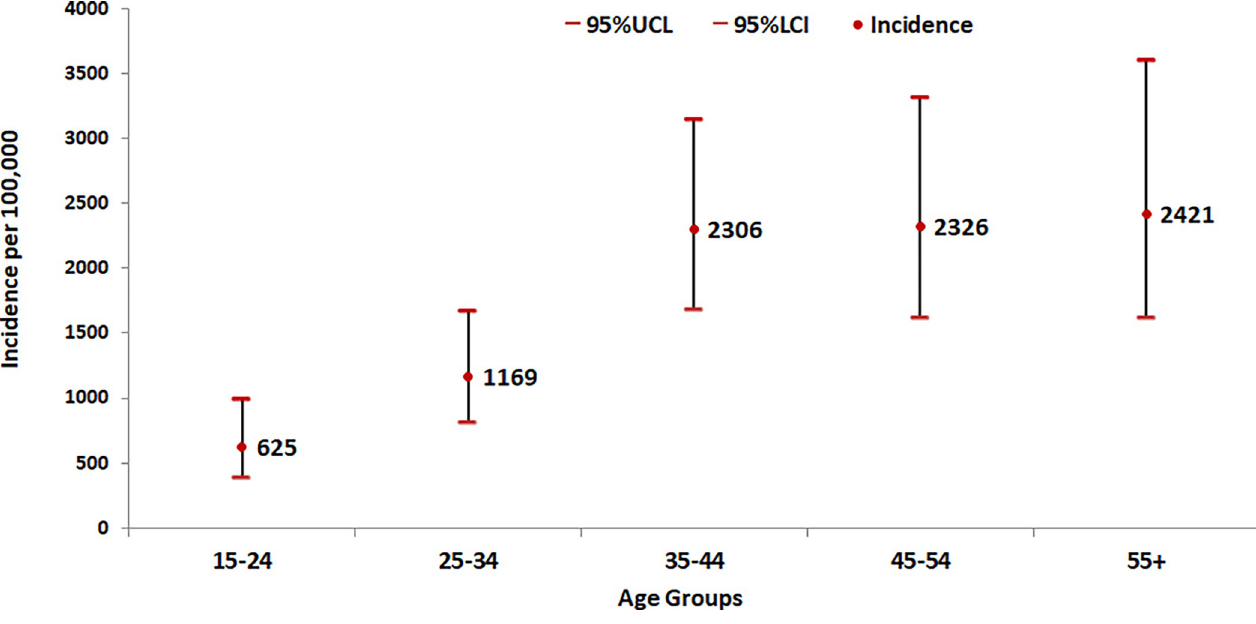
Fig 3. Agewise incidence (smear and/or culture positive) of